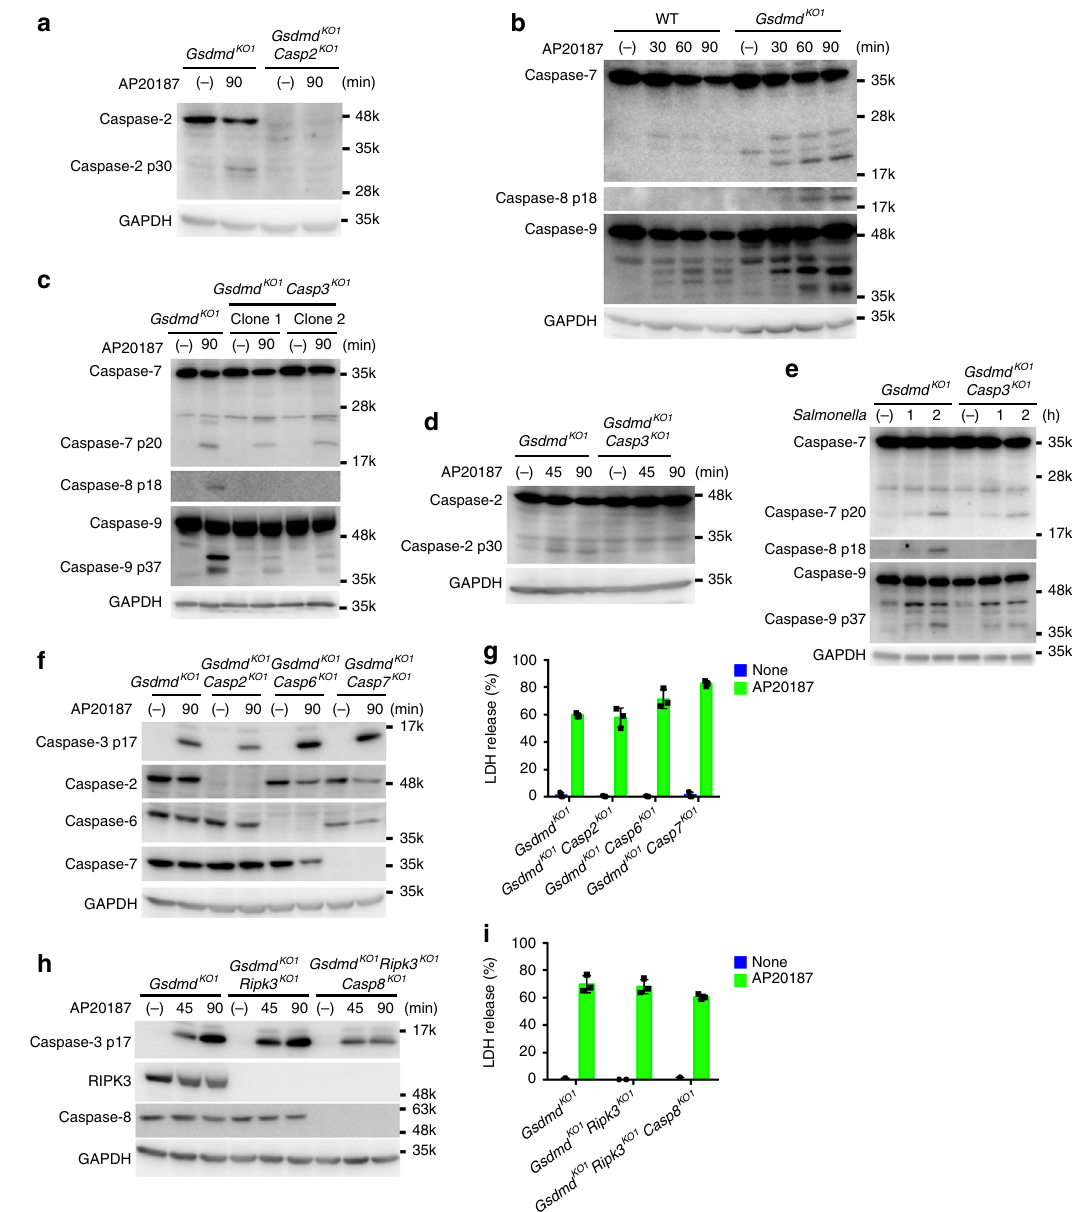
Fig. 4 Caspase-2, 6, 7, and 8 are dispensable for caspase-1-induced apoptosis. a Gsdmd -KO and Gsdmd / Casp2 -DKO CL26-iCasp1 cells were stimulated with 50 nM AP20187 for 1.5 h, and cleaved caspase-2 was detected by Western blotting. b Western blot detection of cleaved caspases in WT and Gsdmd - KO CL26-iCasp1 cells treated with AP20187 for the indicated times. c , d , e Gsdmd -KO and Gsdmd / Casp3 -DKO CL26-iCasp1 cells ( c , d ) and RAW264.7 cells ( e ) were treated with AP20187 and infected with S . Typhimurium as in Fig. 1f, respectively. Cleaved caspases were detected by western blotting. f – i CL26- iCasp1 cells of the indicated genotypes were treated with AP20187 for the indicated times ( f , h ) or 4 h ( g , i). Western blot detection of cleaved caspase-3 and procaspases in the cells ( f , h ). LDH release from the cells ( g , i ). Graphs depict the mean ± SD of triplicate cultures, and individual data values are plotted. Data are from one representative of three independent experiments with similar results ( a – i ). Source data are provided as a Source Data fi le. (See also Supplementary Fig.